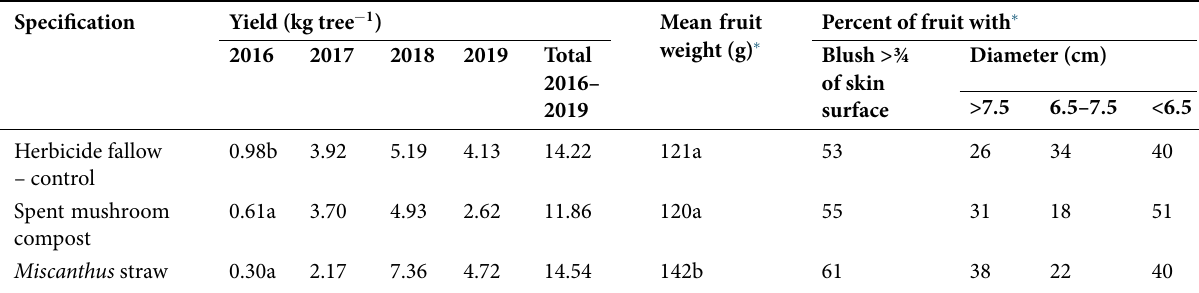
∗ Mean for the years 2016 to 2019. Within individual columns, the means denoted by different letters differ significantly according to Duncan’s test at a confidence level of 95%; the means without letters are